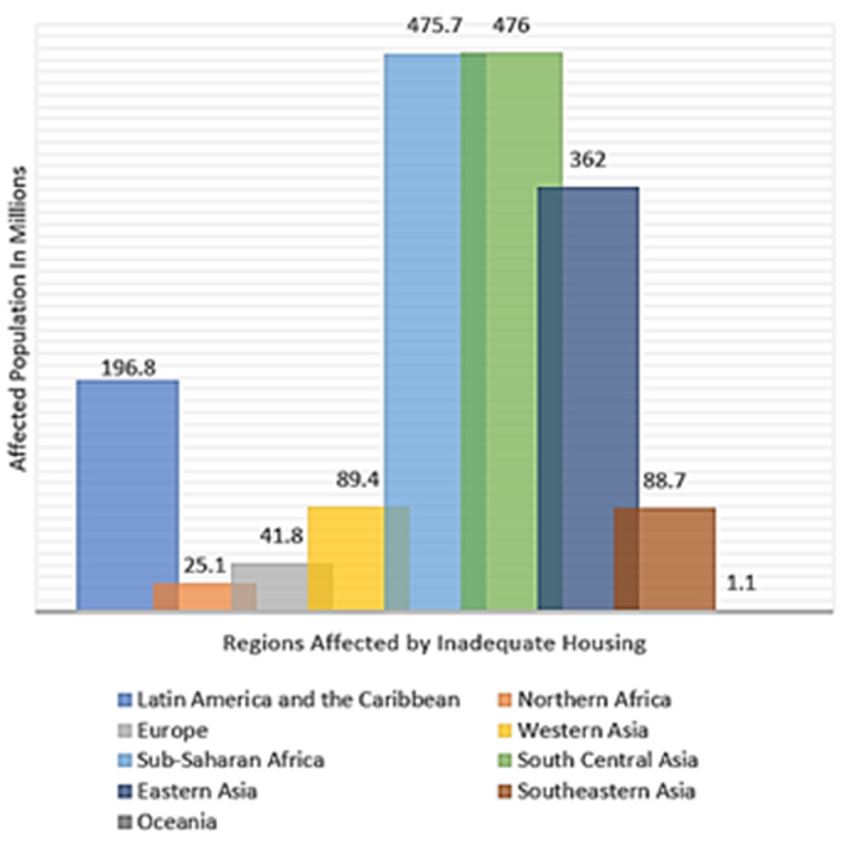
Figure 2. World population affected by inadequate housing, estimation for 2025. Adapted from [2].